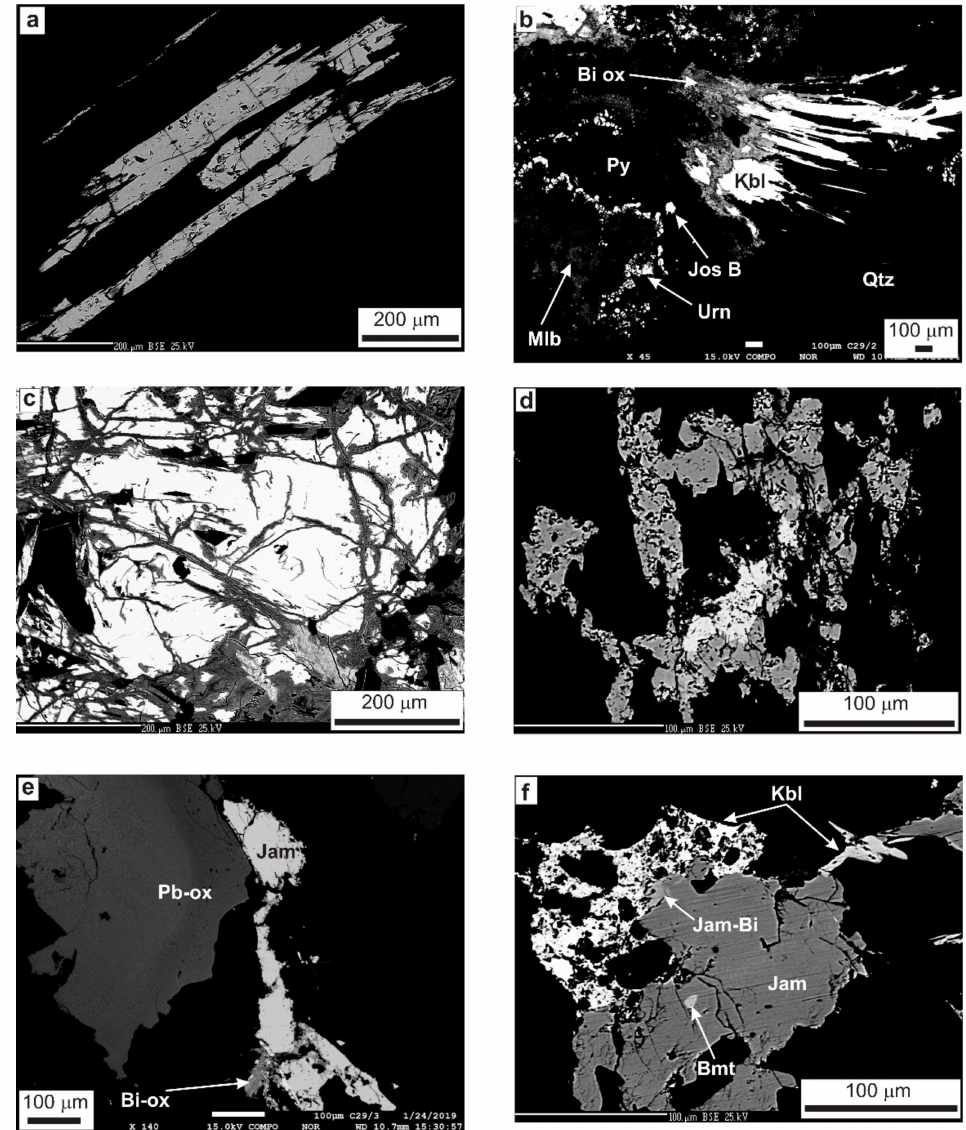
Figure 9. ( a ) Acicular crystals of kobellite–tintinaite series minerals (grey) in quartz (black). ( b ) Aggregate of needle-like crystals of kobellite–tintinaite series minerals (Kbl) in association with pyrite (Py), jos é ite-B (Jos B), ullmannite, uraninite (Urn) and molybdenite (Mlb). Kobellite–tintinaite is partially replaced by supergene oxides of Bi-Pb-Sb (Bi ox). The host mineral is quartz (Qtz). ( c ) Kobellite–tintinaite (white) is replaced by unidentified oxides, Pb-Bi (shades of grey). ( d ) Cosalite (white) associated with minerals of the kobellite–tintinaite series (grey) in quartz (black). ( e ) Irregular veinlet of jamesonite (Jam) in quartz (black) is replaced by unspecified supergene minerals of Sb-Pb-Bi (Bi-ox). The cavity in the quartz is filled with supergene oxides of Pb-Fe (Pb-ox). ( f ) Jamesonite (Jam, Jam-Bi) in contact with kobellite–tintinaite series minerals with enclosed grain of bismuthinite (Bmt). BSE, photos by T. Mikuš ( b , e ) and M. Števko ( a , c , d , f